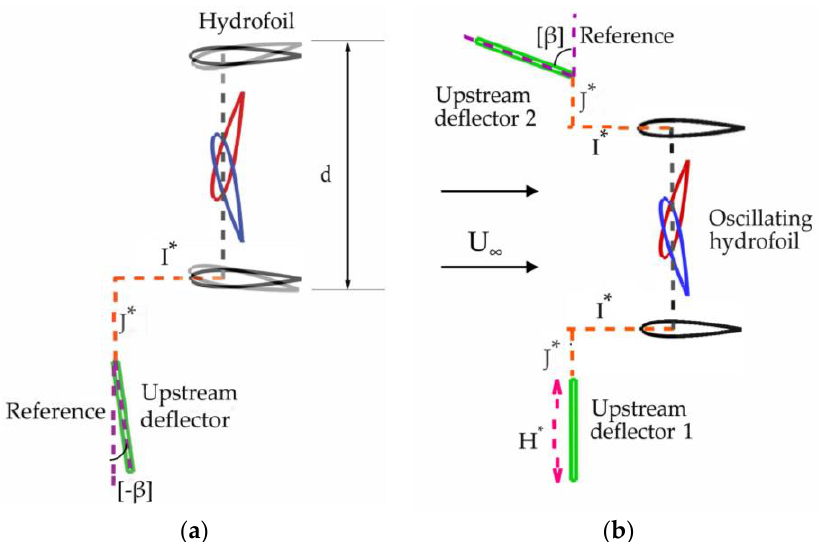
Figure 1. Schematic of the oscillating hydrofoil with an upstream deflector (the red and blue foils represent downstroke and upstroke motion, respectively). ( a ) Single design, ( b ) dual design.